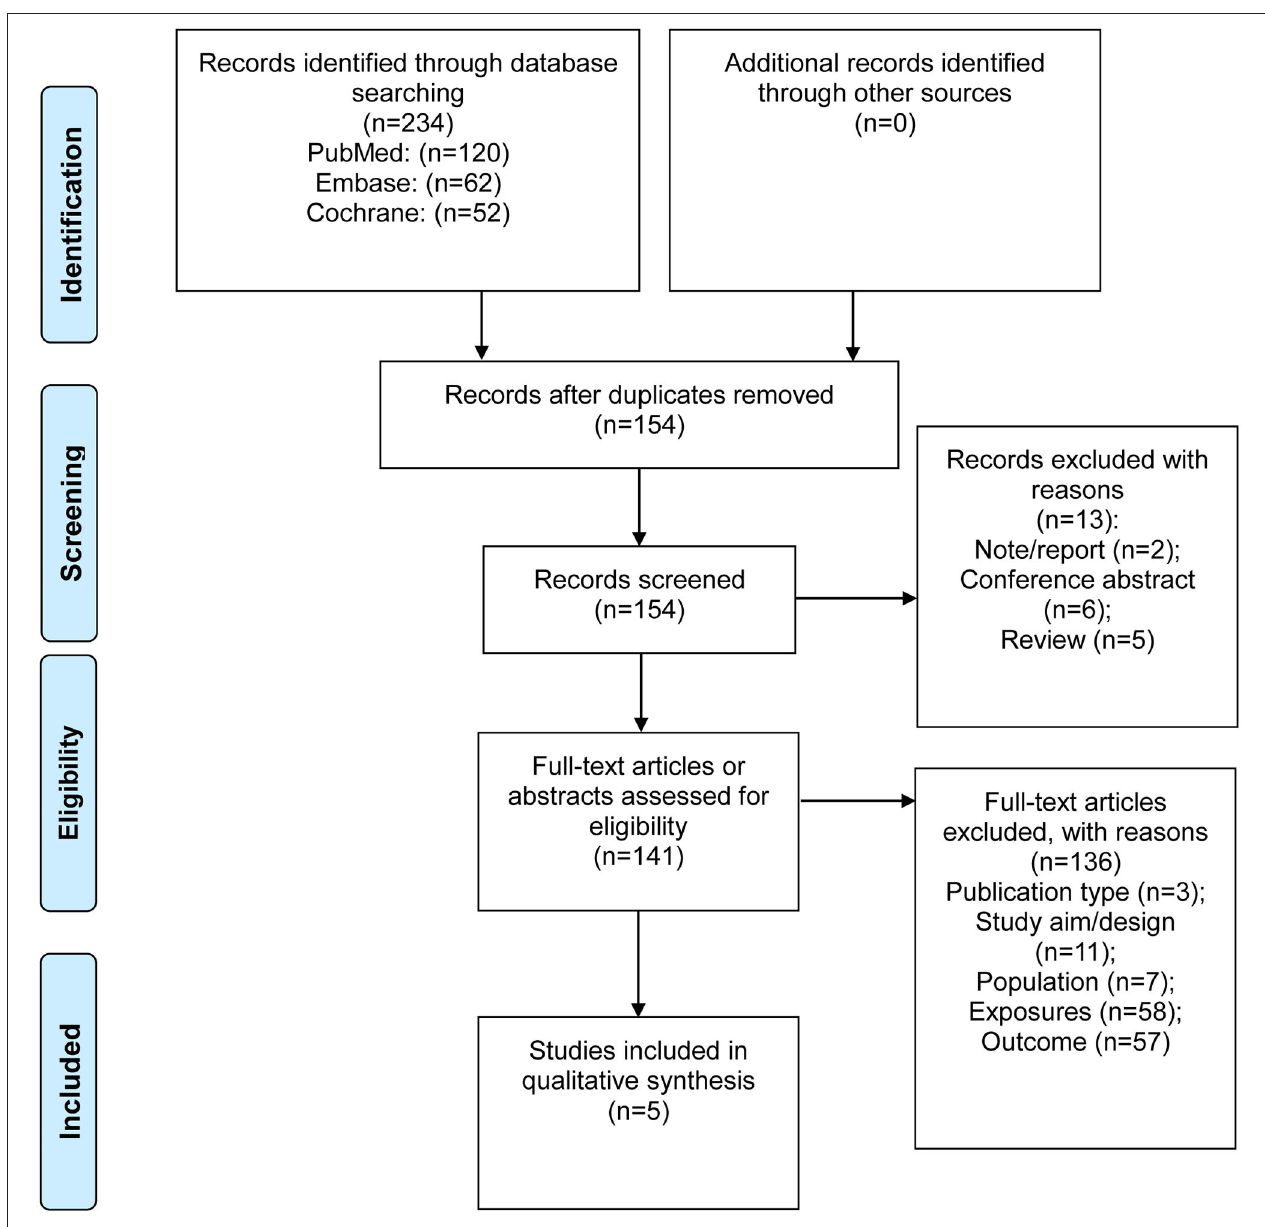
FIGURE 1 | Literature search